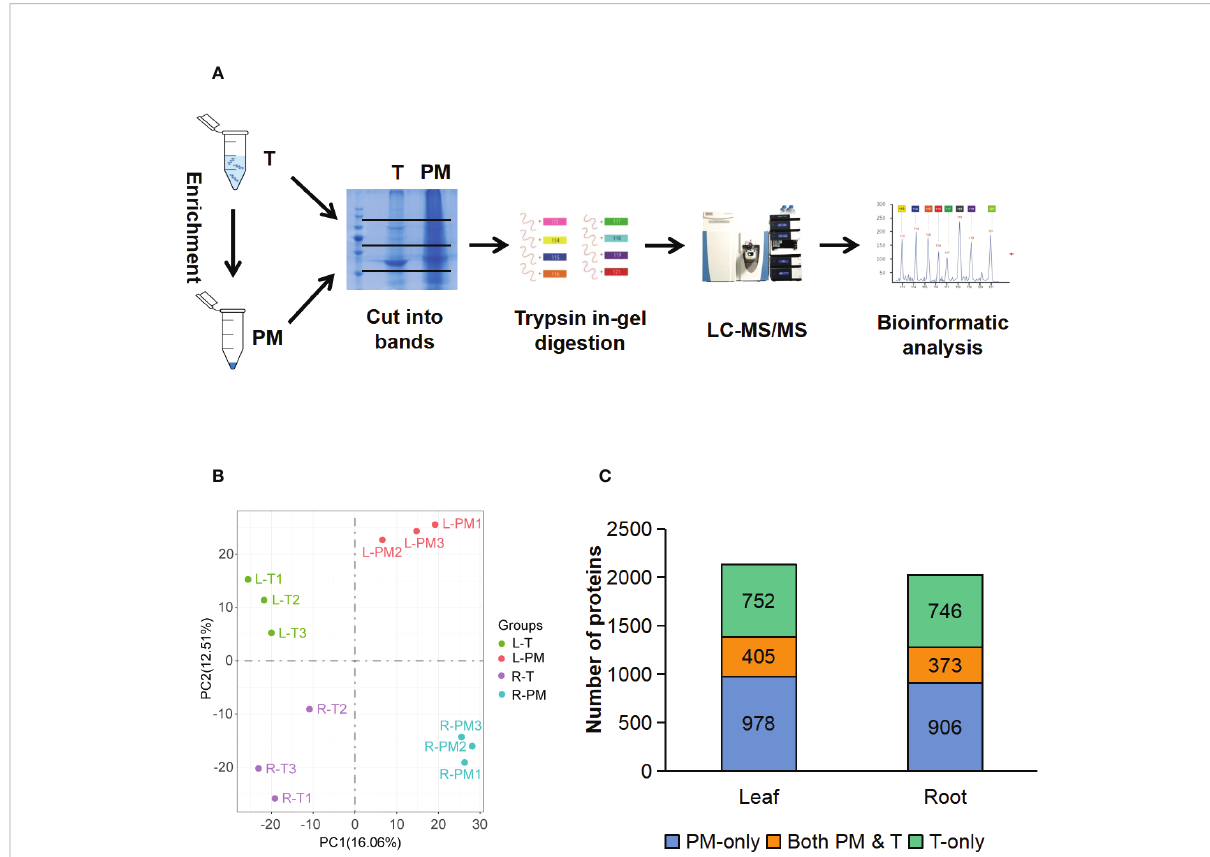
FIGURE 3 LC-MS/MS analysis of the total fraction and enriched plasma membrane fraction. (A) Work fl ow of MS analysis of total and enriched PM fraction. (B) PCA analysis of proteome data from the total and enriched PM fraction of leaf and root tissue, three biological replicates for each fraction of each tissue type. (C) Comparison of proteins identi fi ed in total fraction alone (green blocks), enriched PM fraction alone (blue blocks), and shared by both fraction (orange blocks). T, total fraction; PM, enriched plasma membrane fraction; L-T, total fraction of leaves; L-PM, enriched plasma membrane fraction of leaves; R-T, total fraction of roots; R-PM, enriched plasma membrane fraction of